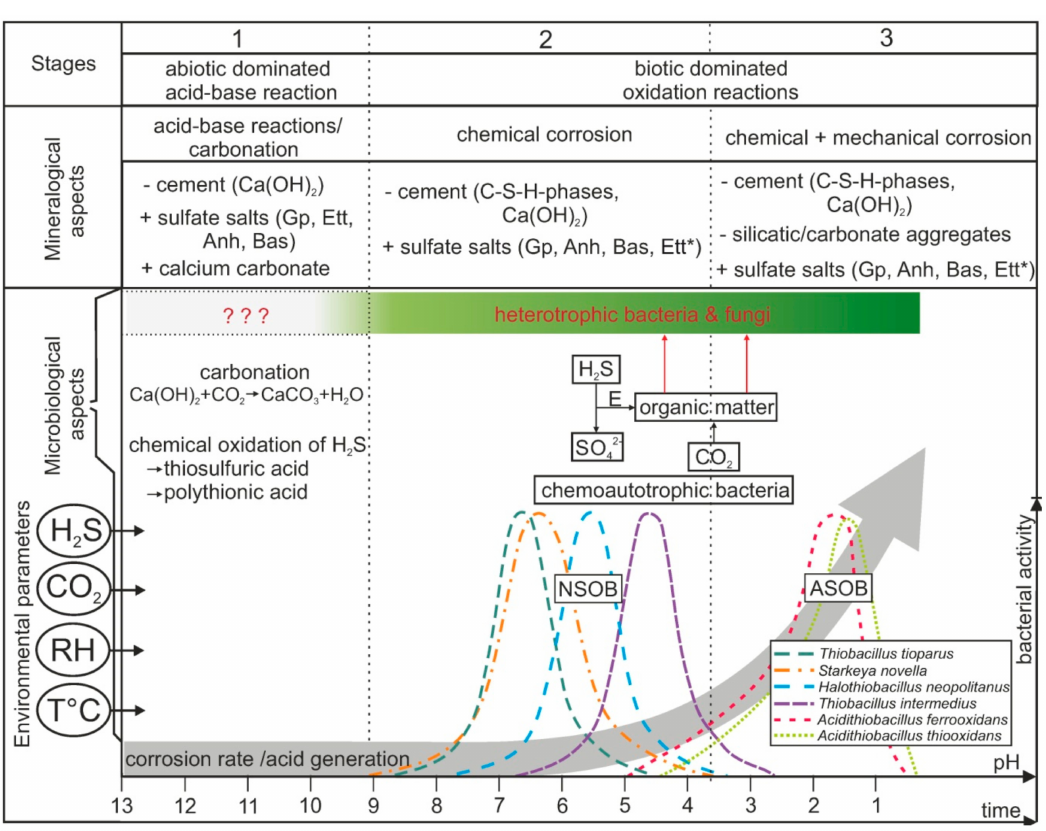
Figure 3. Mineralogical, Chemical and Biological conditions for biotic dominated and abiotic dominated corrosion [17]. “Reproduced with permission from Grengg, C.; Mittermayr, F.; Ukrainczyk, N.; Koraimann, G.; Kienesberger, S.; Dietzel, M., Water Respublished by Elsevier,